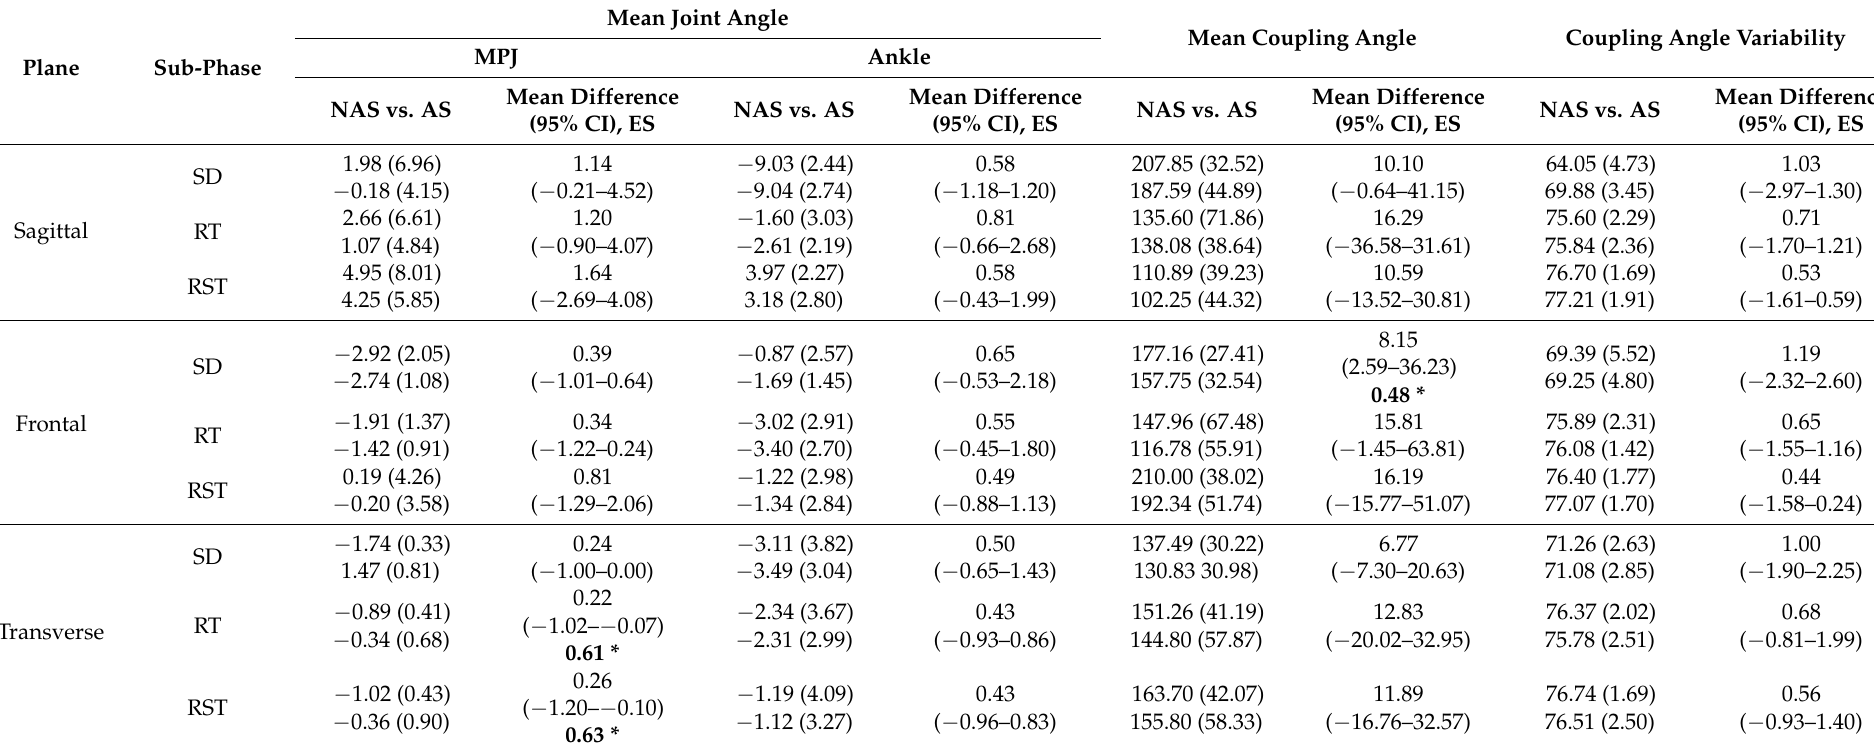
Table 1. The joint angle of MPJ and ankle, mean coupling angle, and coupling angle variability [mean (standard deviation)] per sub-phase of unplanned gait termination.